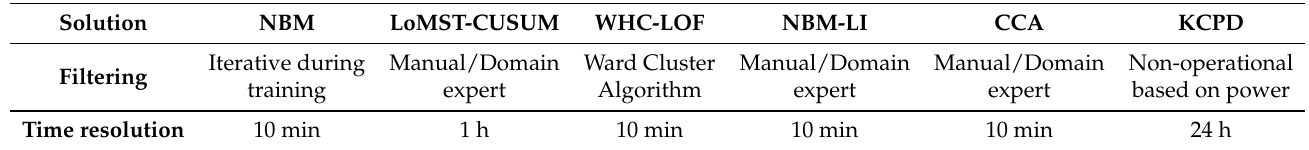
Table 4. Overview of data pre-processing approaches by